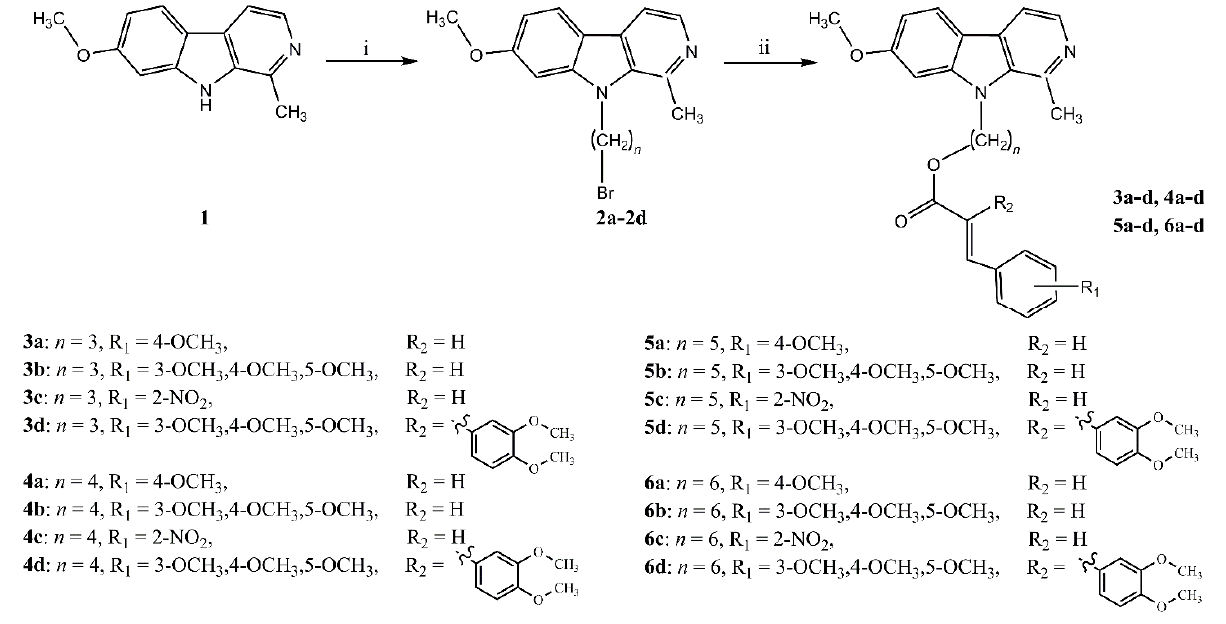
Figure 2. ORTEP diagram for compound 4a with ellipsoids set at 75% probability. 2.2. Evaluation of the Antibacterial Activity According to microplate dilution method, all the prepared compounds were screened for their in vitro antibacterial activity. The investigation included three repre- sentative Gram-positive strains, including Staphylococcus aureus CICC 10384 ( S. aureus ) , Staphylococcus albus CICC 20237 ( S . albus ) and methicillinresistant Staphylococcus aureus ATCC 43300 (MRSA) , and two representative Gram-negative strains, including Esche- richia coli CICC 10389 ( E . coli ) and Pseudomonas aeruginosa CVCC 3359 (PA). Harmine and cinnamic acid were used as reference drugs. The results of minimum inhibitory concen- tration (MICs) are presented in Table 1. It showed that most of the synthesized harmine derivatives displayed better antibacterial activities against Gram-positive strains ( S . au- reus, S . albus and MRSA) than Gram-negative strains ( E . coli and PA). Notably, Com- pounds 3c and 5a displayed attractive antibacterial activities than other